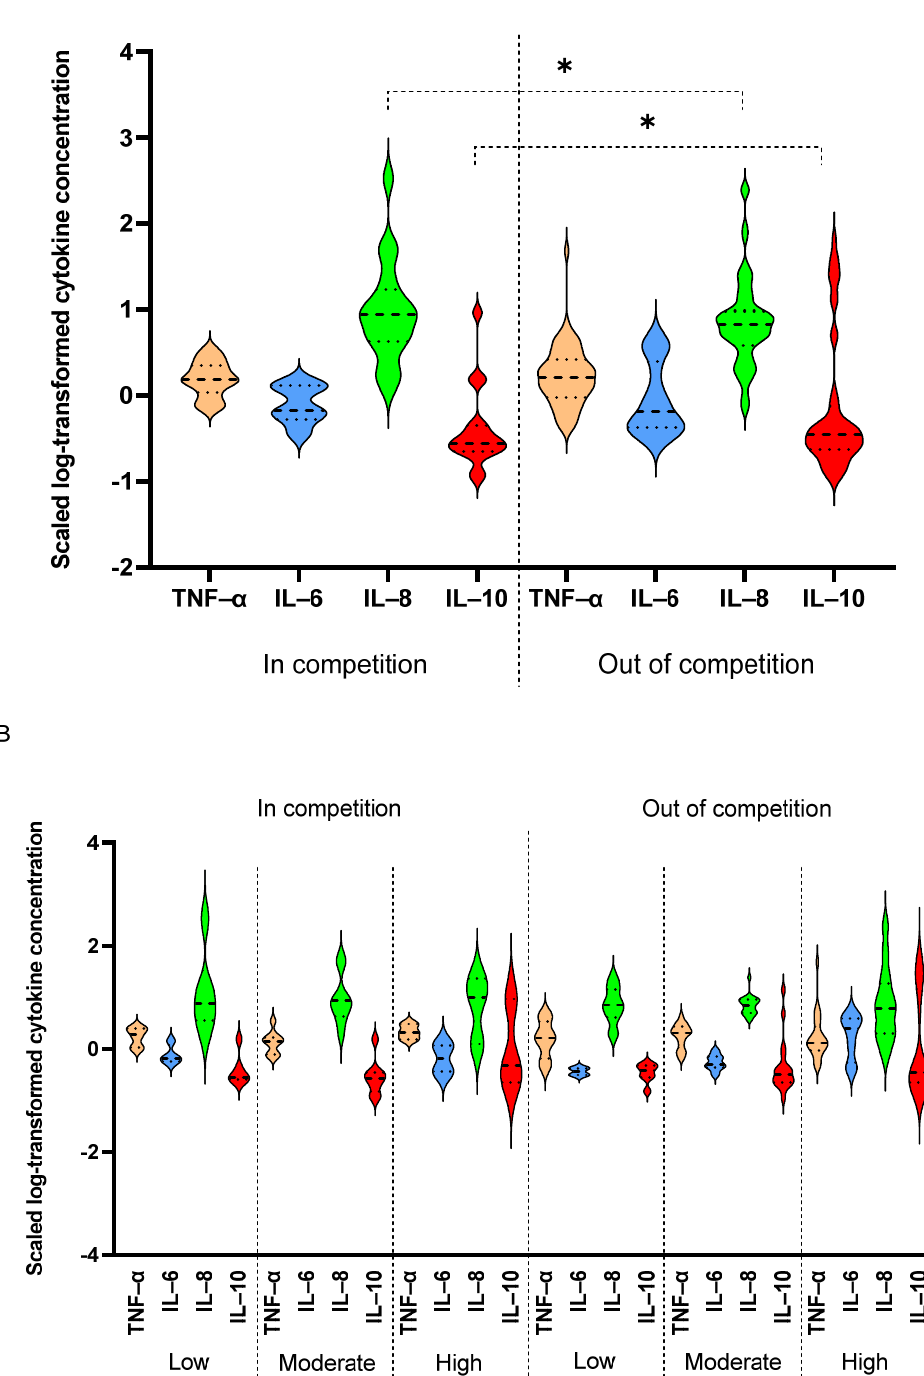
Figure 5. Comparing levels of cytokines in competing and out of competition athletes. Levels of TNF- α , IL-6, IL-8 and IL-10 cytokines were compared between in competition ( n = 20) and out of competition ( n = 60) elite athletes ( A ) in different sport intensities (low, n = 18, moderate, n = 31 and high, n = 31) ( B ). Linear regression model was used to compare cytokine levels in different age and sport intensity groups taking gender and in/out of competition status as potential confounders. Data are presented as median and IQR. * p <